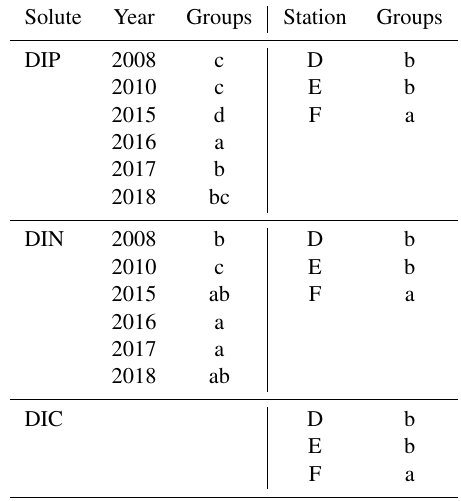
Table A3. Results from Student–Newman–Keuls (SNK) tests. For years or stations with different group letters, the average fluxes differed significantly. Fluxes were highest in groups named a, with decreasing fluxes in groups following alphabetical